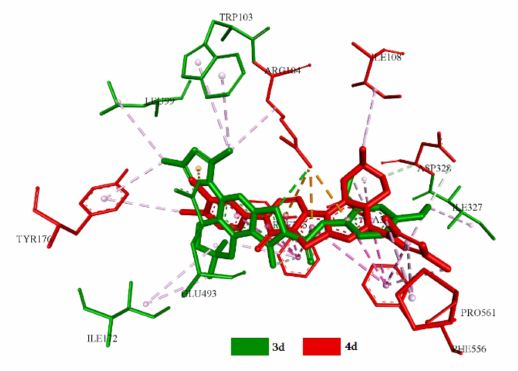
Figure 10. Superstation position of 3d and 4d in the central site of the active center of SERT.